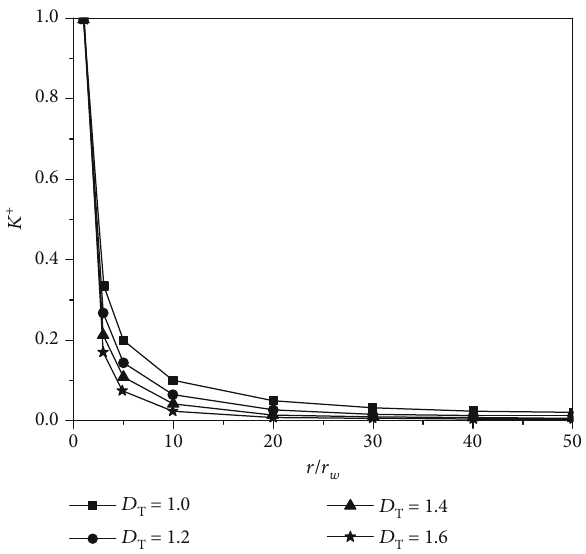
and D ( β = 0 : 01 , θ = π /6 , xx f